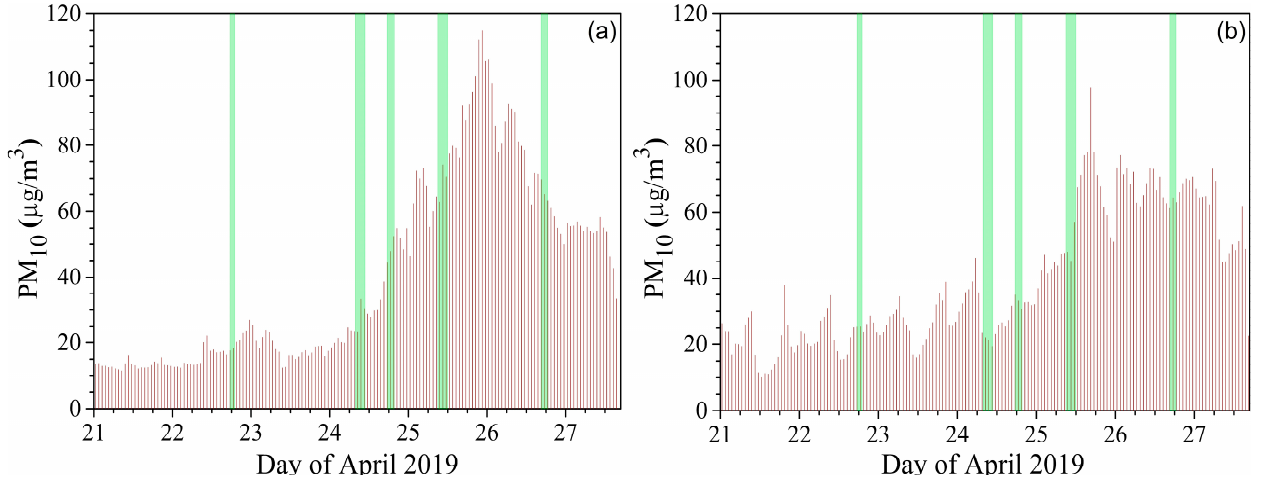
Figure 11. Hourly mean values of the PM 10 mass concentrations measured by the ( a ) Kopitoto AMS (BG0070A) and ( b ) Mladost AMS (BG0079A) in the period 21–27 April 2019. The vertical green bars indicate the time intervals of the lidar measurements.